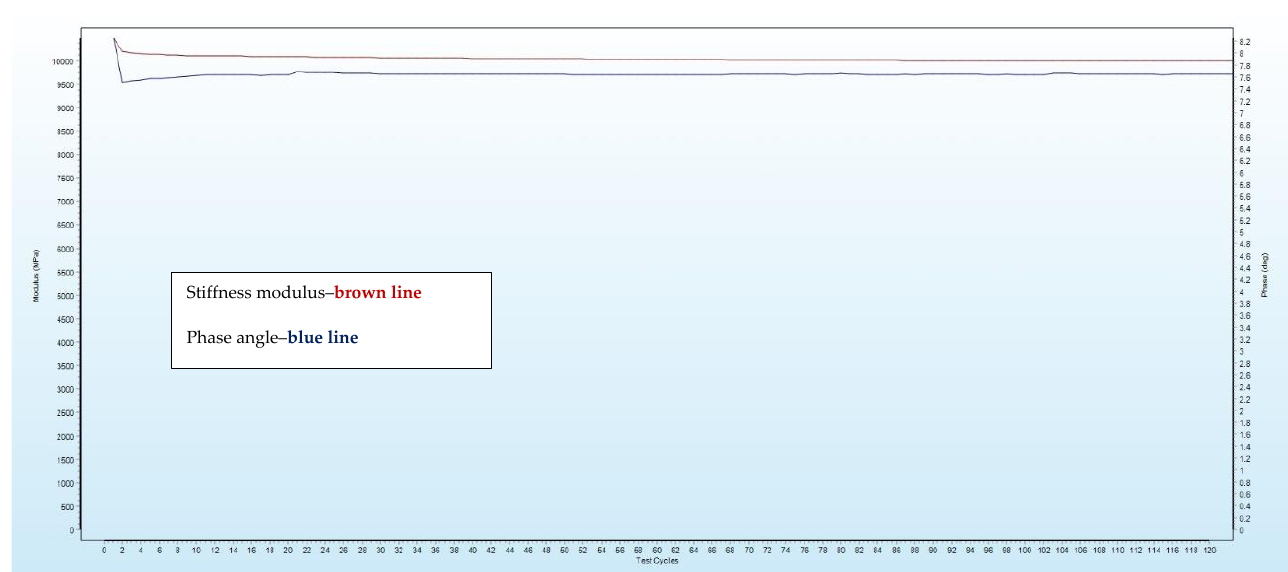
Figure 6. Sample result registered by testlab software.